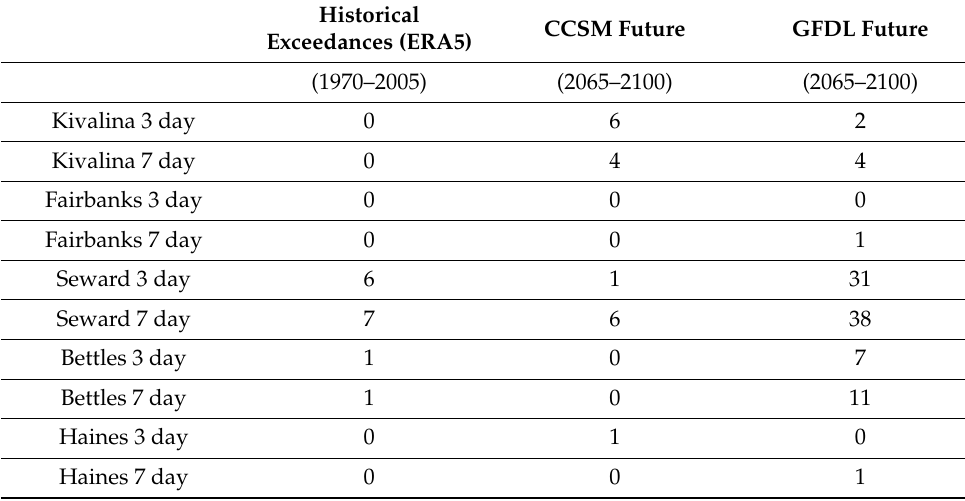
Table 3. Numbers of exceedances of 3 day and 7 day precipitation amounts corresponding to the actual flood